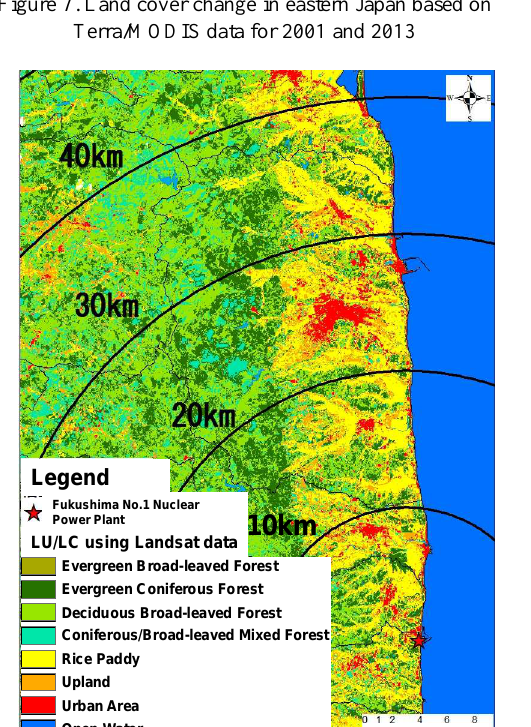
Figure 8. Land Cover Map in Fukushima Prefecture based on Landsat TM data during 2000 and